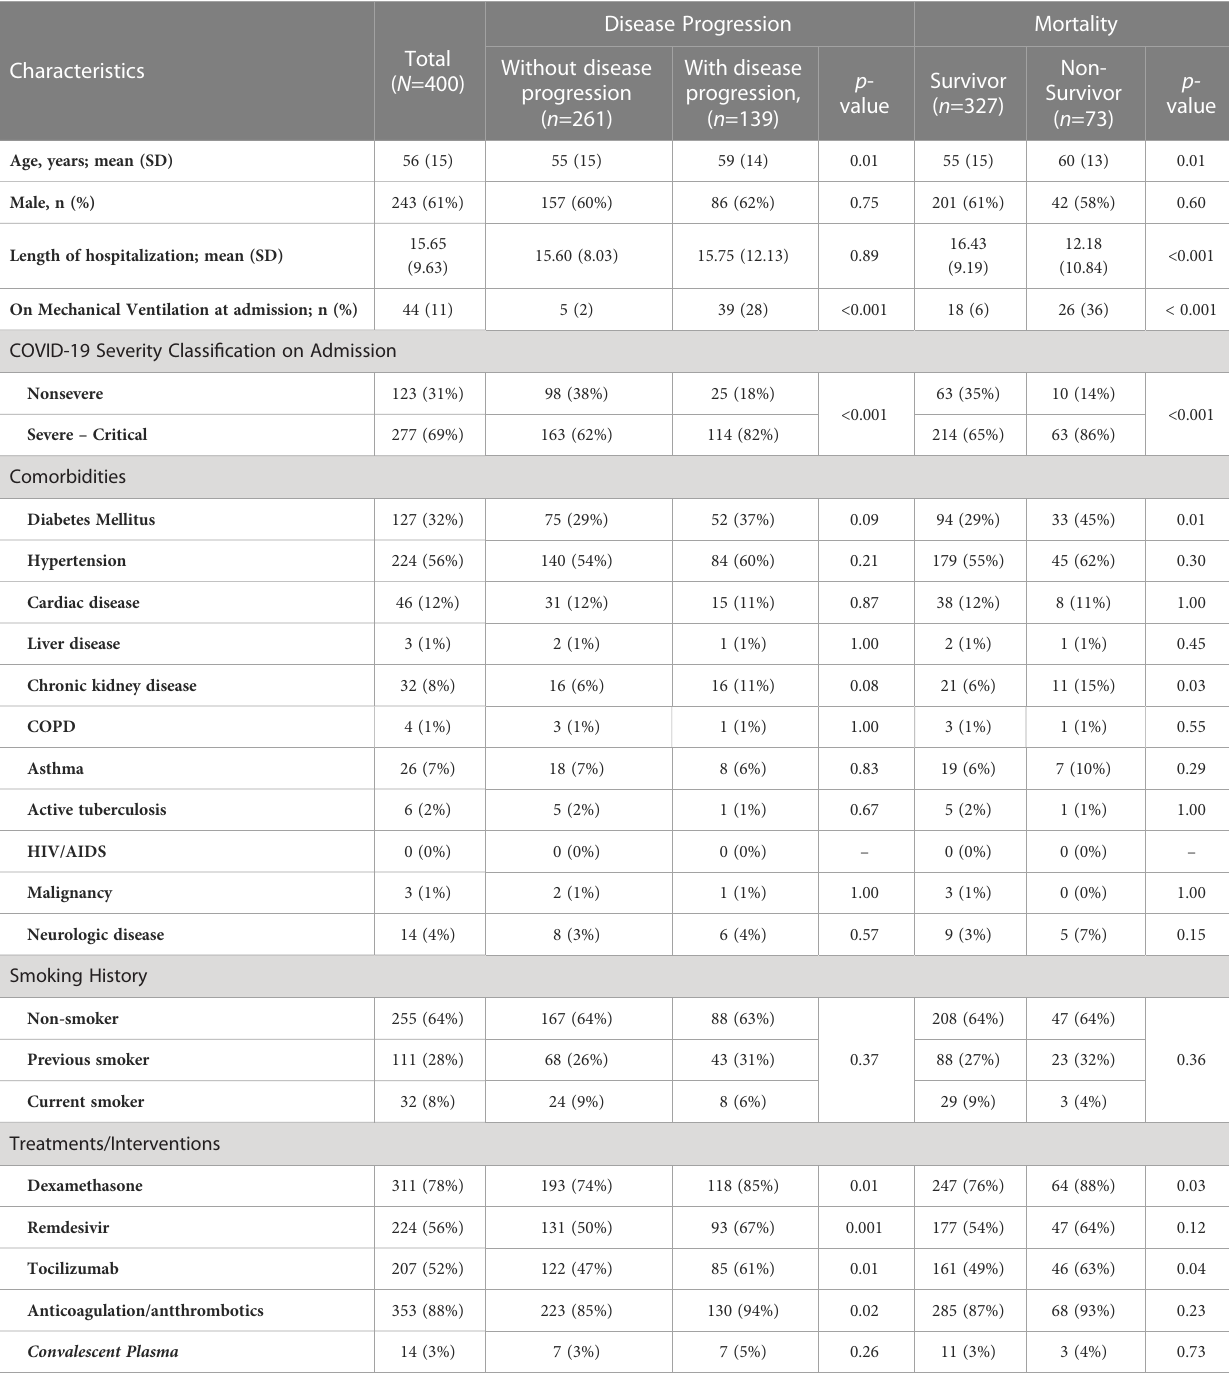
TABLE 1 Comparison of demographic and clinical characteristics of hospitalized adult patients with con fi rmed COVID-19 according to outcomes of disease progression and